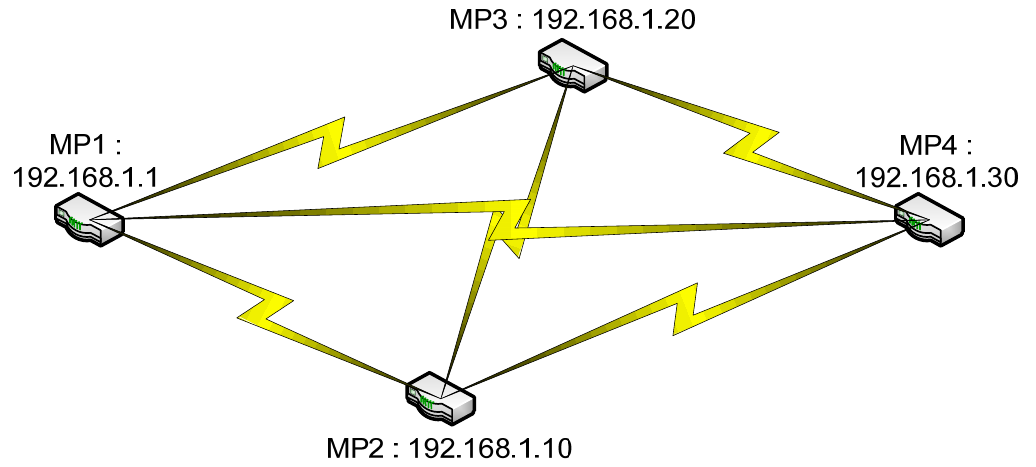
Figure 5. The mesh topology used to determine the path selected in the dynamic routing mode.